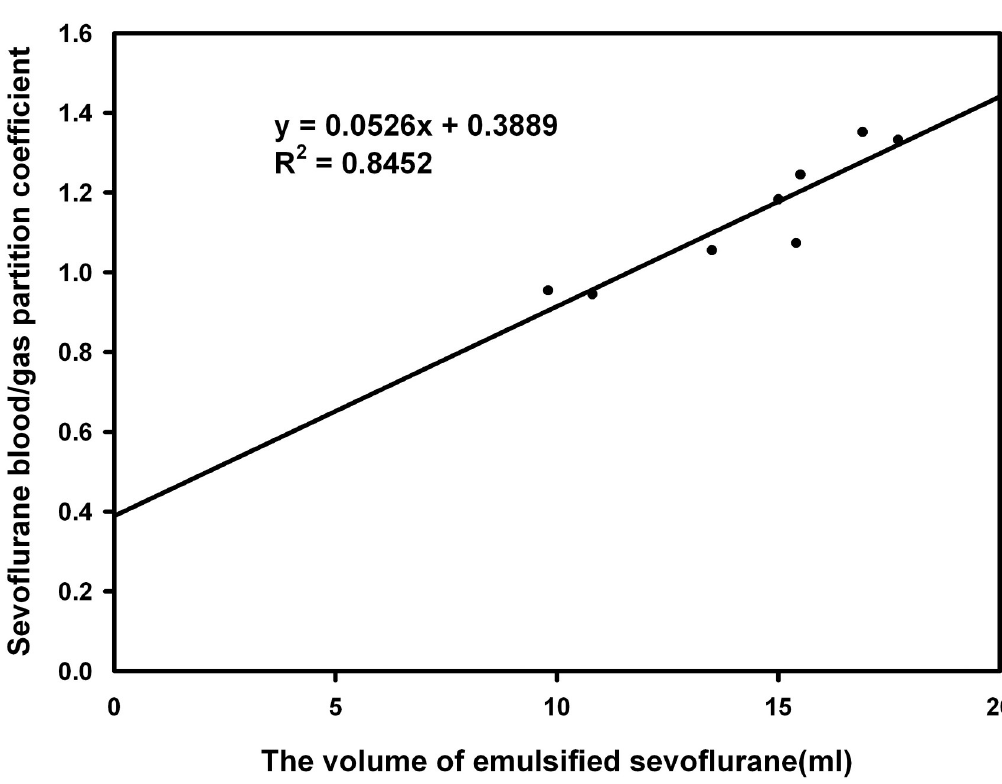
Fig 3. The positive correlation between sevoflurane blood/gas partition coefficient and the volume of emulsified sevoflurane delivered.